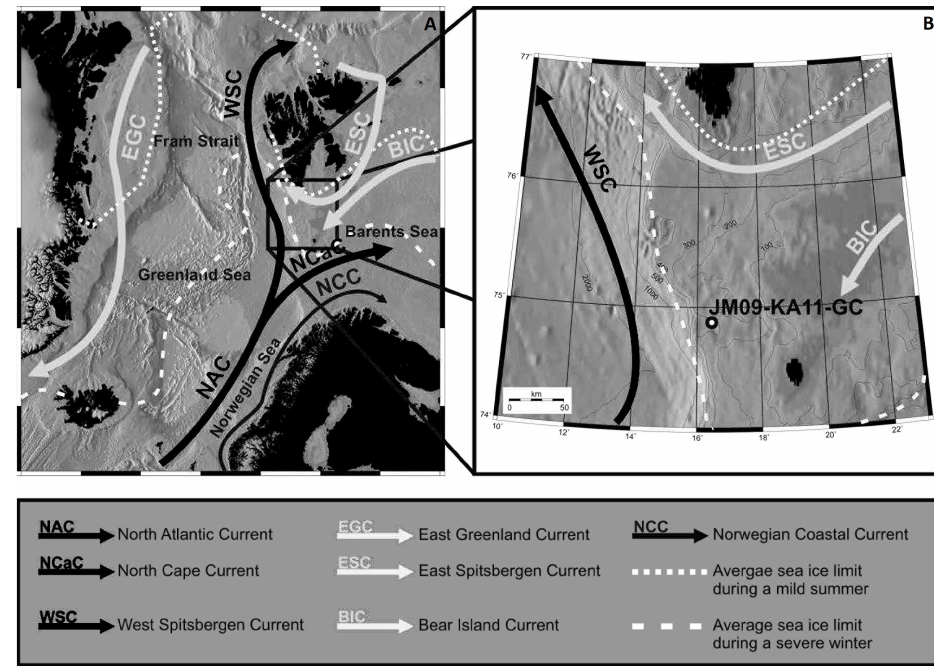
Fig. 1. (A) Surface currents in the high-latitude North Atlantic and north-western Barents Sea are presented on a bathymetric map. Water masses and sea ice distribution are defined according to Hopkins (1991). (B) Close up of the study site showing the core location of JM09- KA11-GC. The core was retrieved in the Kveithola Trough surrounded by the Spitsbergen Bank at a water depth of